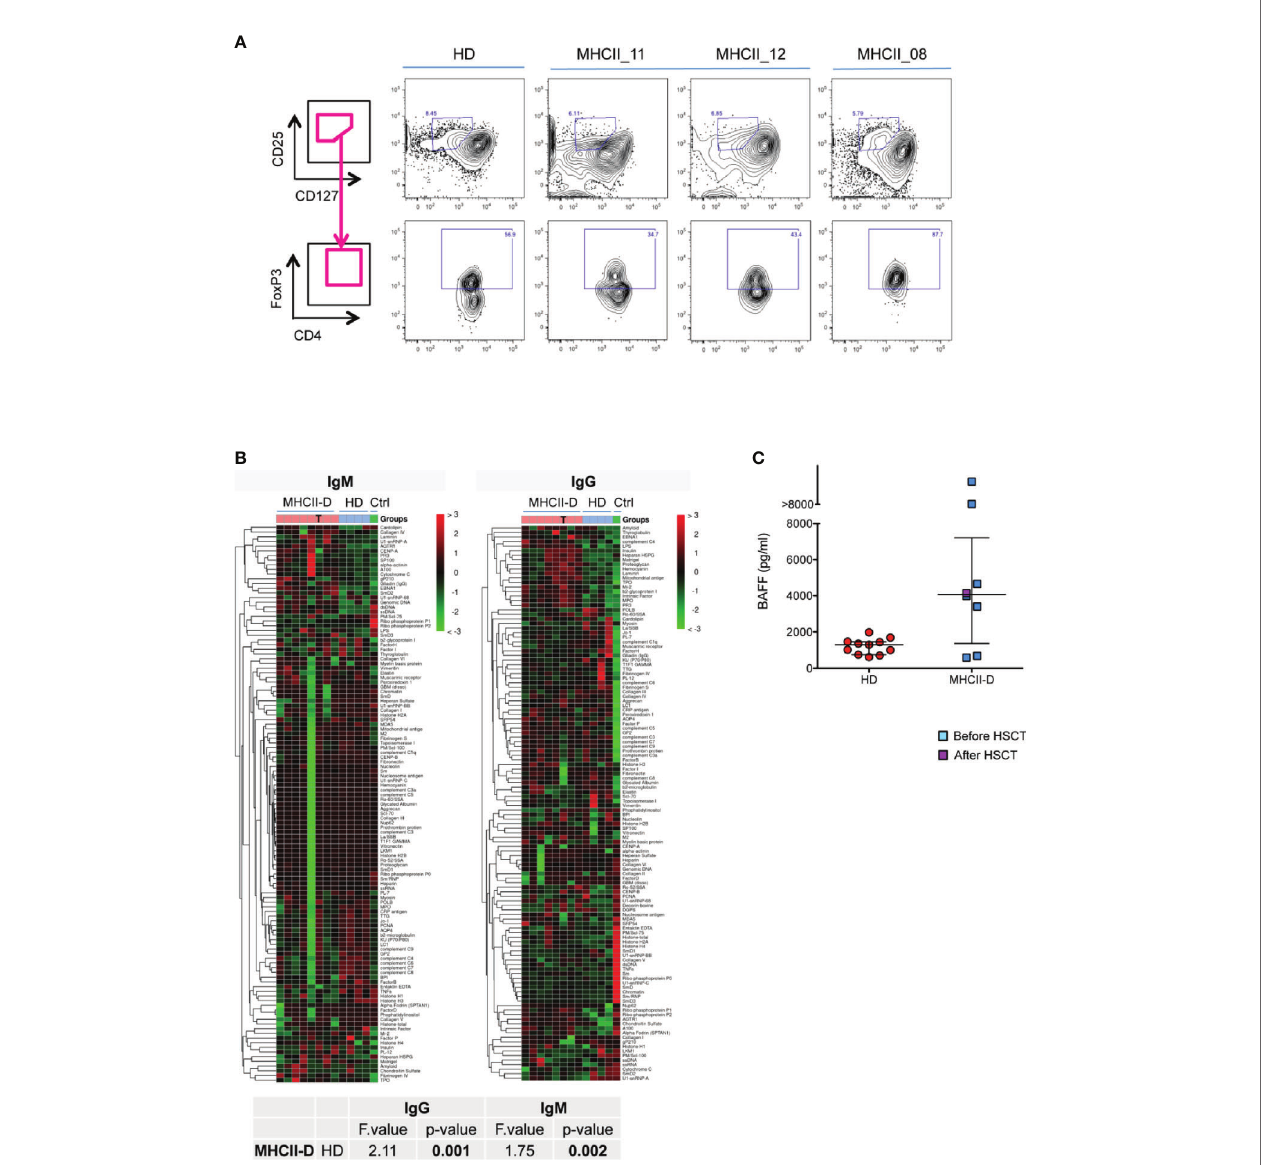
FIGURE 7 | Peripheral tolerance impairment in patients with MHCII de fi ciency. (A) Treg cell frequency in MHCII-D patients. Representative FACS plots of Treg cells in three patients with MHCII-D and a HD. Treg cells are de fi ned as CD4 + CD25 hi CD127 lo FOXP3 + cells. In upper panels CD25 hi CD127 lo cells are represented, gated on CD4 + T-cell gate. In lower panels, FOXP3 + cells are represented, gated on CD25 hi CD127 lo cells. FOXP3 gate was set based on fl uorescence-minus-one (FMO) control on normal donor cells. (B) Autoantibodies are present in the serum of MHCII-D patients. Patients ’ serum was tested for the presence of a large panel of 95 autoantibodies. Heatmap colors correspond to z-score, i.e. the number of standard deviations from the mean signal intensity of the autoantibody across all samples. Color legend over the panel show: pink box, MHCII-D patients; light blue box, age matched normal controls (HD); green, positive control (serum of a patient with systemic lupus erythematous, kindly provided by Stefano Volpi, Genova, Italy). T symbols identify the sample of a MHCII-D patient after HSCT. Statistical analysis included only not transplanted MHCII-D patients. (C) BAFF level in MHCII-D patients ’ sera. Serum BAFF concentration was determined by ELISA in 11 age-matched healthy controls (HD) and in eight MHCII-D patients (one of whom after HSCT). Each symbol represents an individual, and the median is represented with a horizontal bar. Error bar shows the interquartile